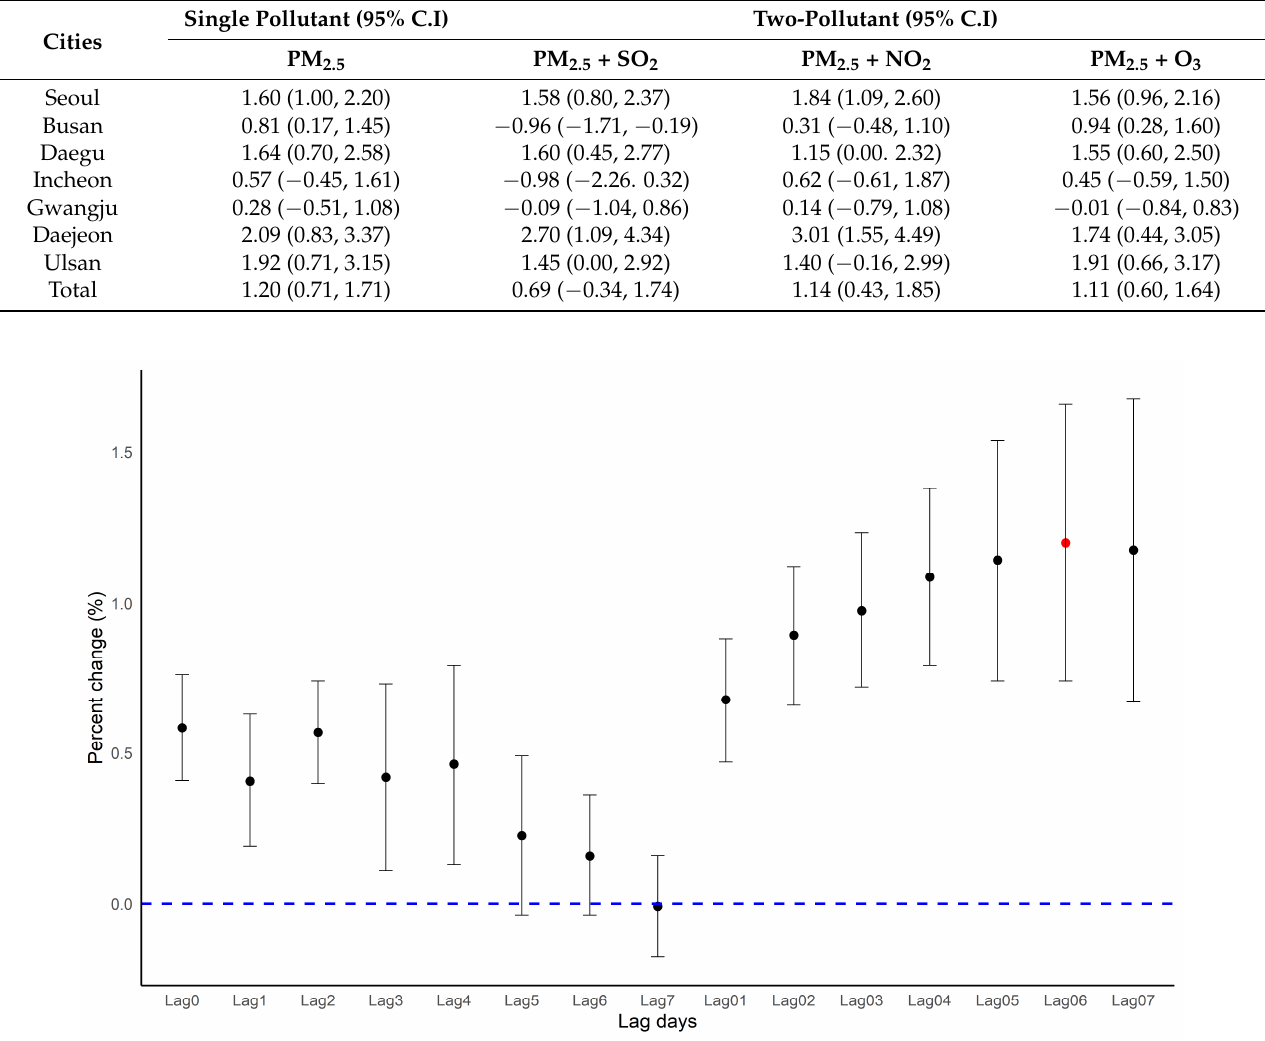
Figure 5. Percentage change (%) for ALRI hospitalizations following single lag days (lag 0 to lag 7) and moving average (lag 01 to lag 07) PM 2.5 exposure in the meta-analysis. Time-series model adjusted for the same covariates (time, AT, day of weeks). The percentage change is calculated as the change per PM 2.5 10 μg/m 3 increase. The blue line means the border line. The red circle means the highest percentage change.